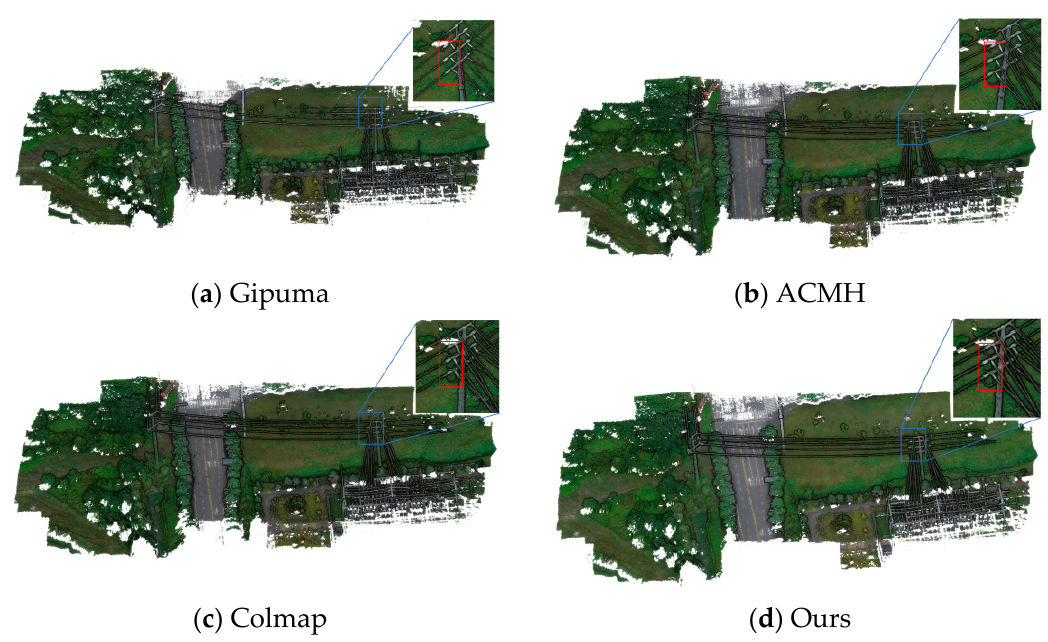
Figure 9. The comparison of reconstructed point clouds of power lines in test site 3. ( a – d ) are generated by Gipuma, ACMH, Colmap, and the proposed method, respectively.